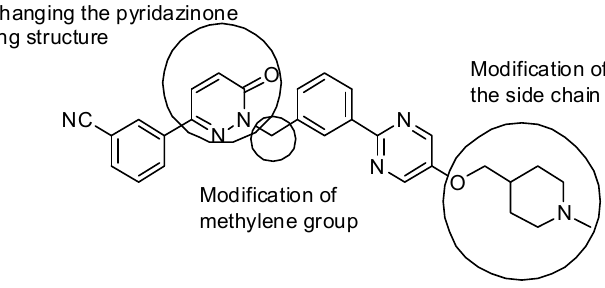
Figure 2. Design of new Tepotinib derivatives.